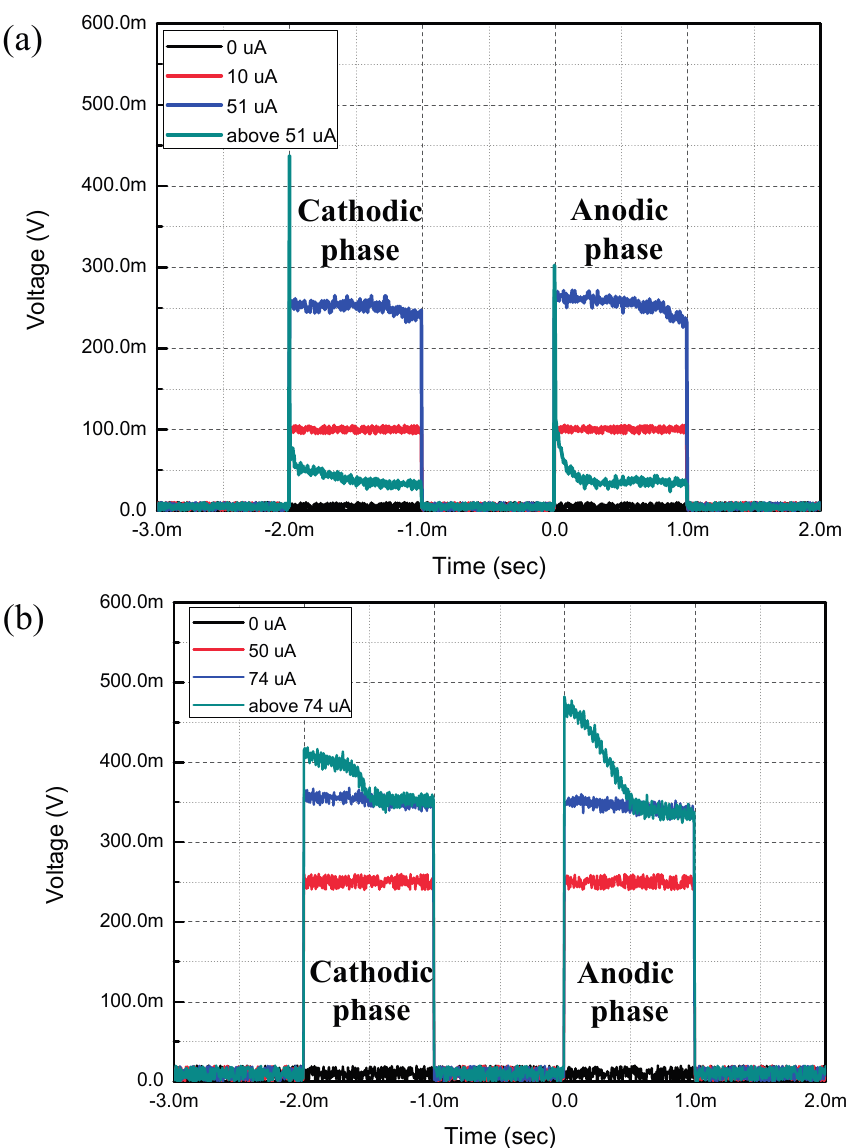
Figure 4. Time domain output of electrical durability evaluation. ( a ) 2D Au microelectrode; ( b ) 3D Au